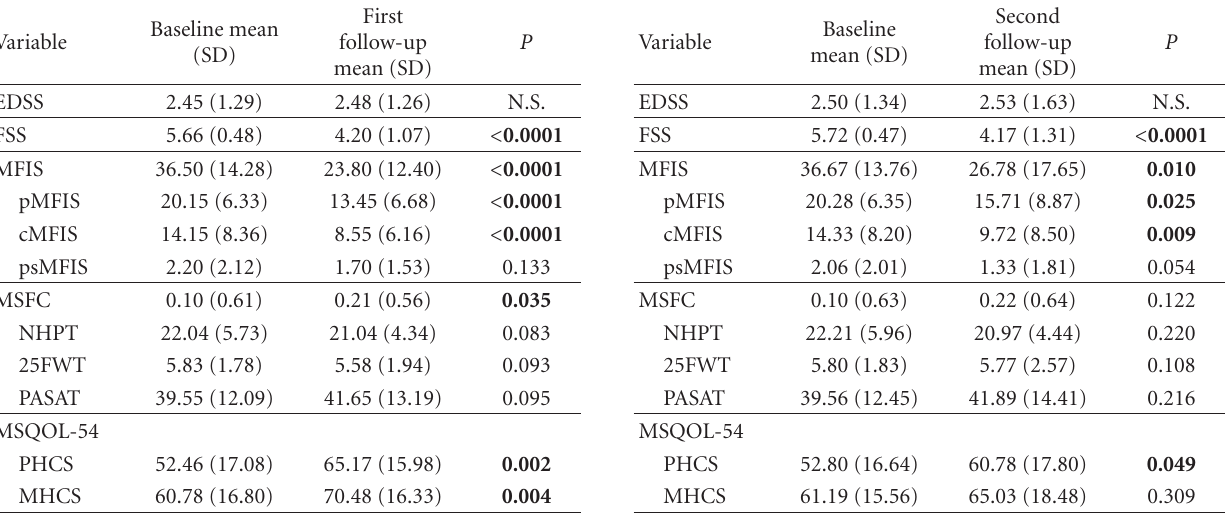
Table 1: Mean clinical variable scores at baseline and after five weeks of treatment ( n = 20).